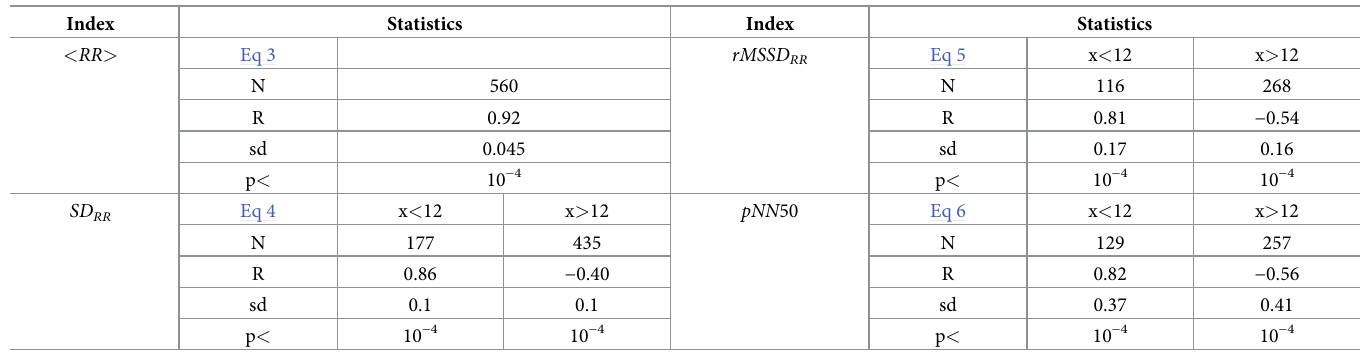
Table 7. Statistics of Eqs 3, 4, 5 and 6.